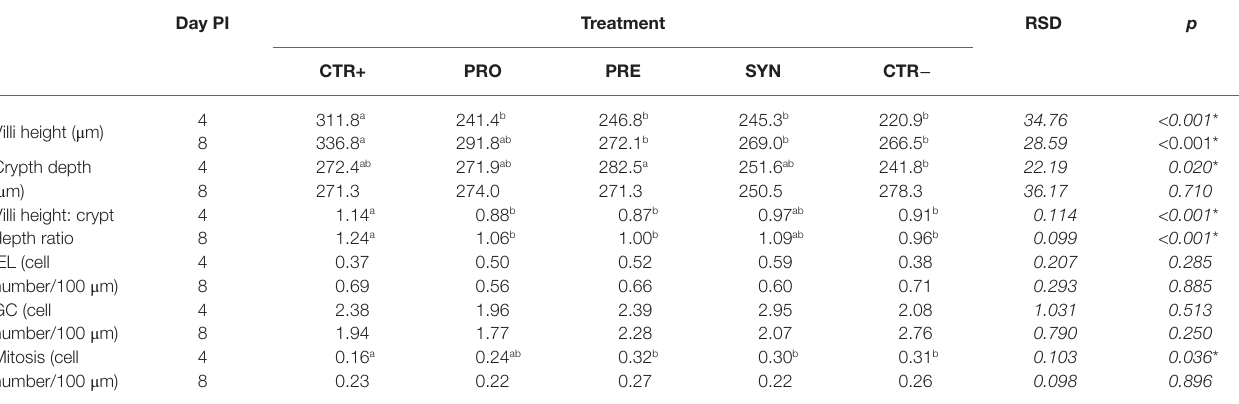
CTR+: non-inoculated animals receiving placebo; PRO: inoculated animals receiving the probiotics; PRE: inoculated animals receiving the prebiotic; SYN: inoculated animals receiving the synbiotic; CTR − : inoculated animals receiving placebo. N = 6 for all groups except for non-challenged animals (N = 8). Values of p were obtained by an ANOVA using the generalized linear procedure in R software. a,b Indicate statistically significant differences between groups. GC, Goblet cells; IEL, intraepithelial lymphocytes, PI, post-inoculation; RSD, relative standard deviation. To differentiate RSD and values of p from the results numbers, they are in italics. *indicates that values of p are <0.05 and statistical difference is